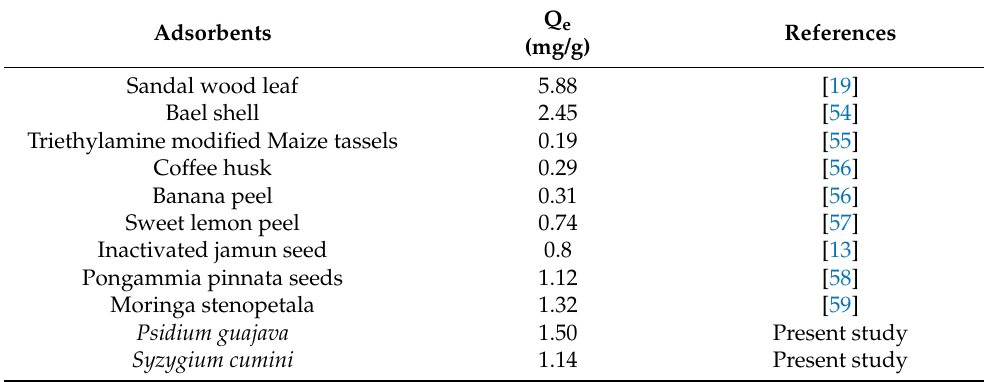
Table 8. Comparison of adsorption capacities of various biosorbents in F − removal. Adsorbents